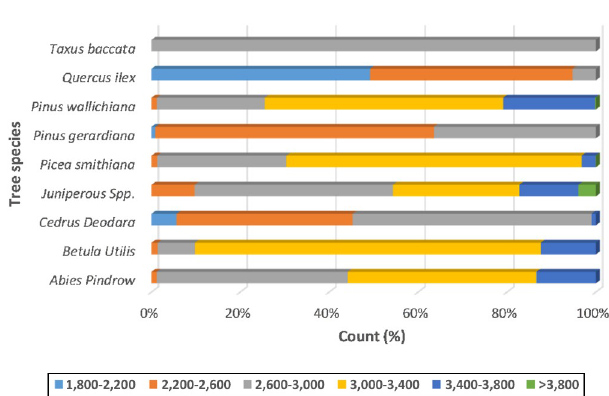
Figure 5. Species-wise percentage distribution of tree counts according to elevation